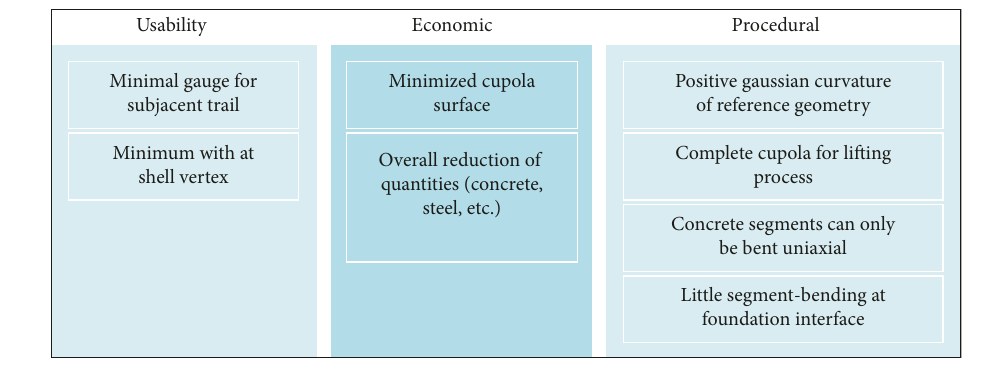
Figure 4: Classification of requirements.